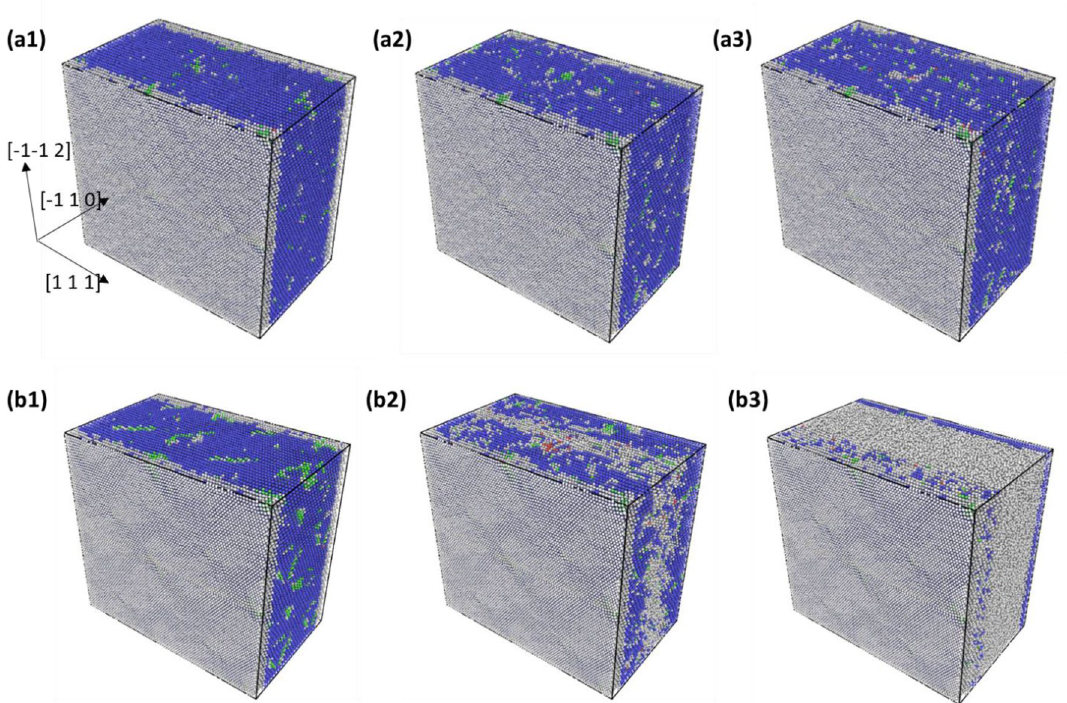
Figure 6. Common neighbor analysis colormap for BCC alloy structure: ( a1 – a3 ) are for the 5 MC swap and ( b1 – b3 ) are for the 15 MC swap structure under the application of 1500 MPa shear stress. Structures are taken approximately 50 ps apart in simulation time. Figure was made using OVITO 2.9.0. URL: https ://www.ovito .org/.